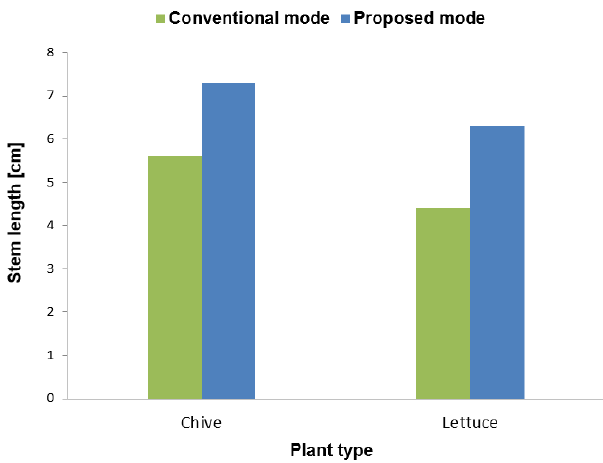
Figure 9. Plant cultivation comparison between conventional and proposed modes over two weeks.